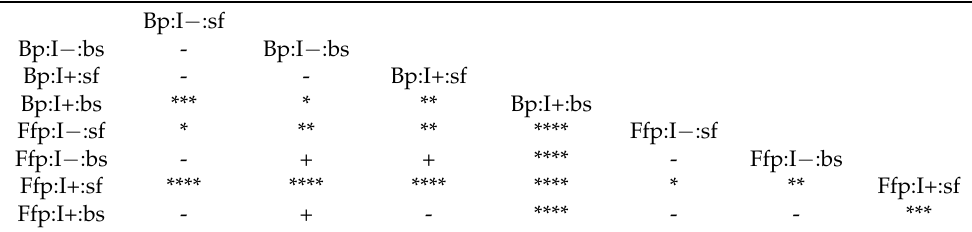
Table 3. Pair-wise comparison of Myzus persicae survival curves for eight days after exposure to a spray of B. bassiana and/or release on B. bassiana -inoculated plants. Treatments were based on combinations of plant type (Bp: B. bassiana -inoculated plant; Ffp: fungal-free plant), insect